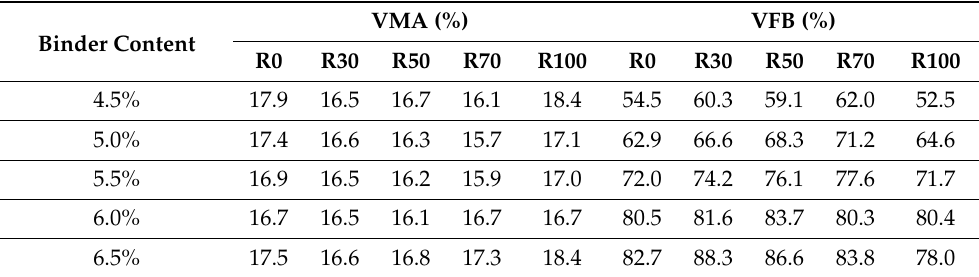
Table A3. VMA and VFB result in various binder